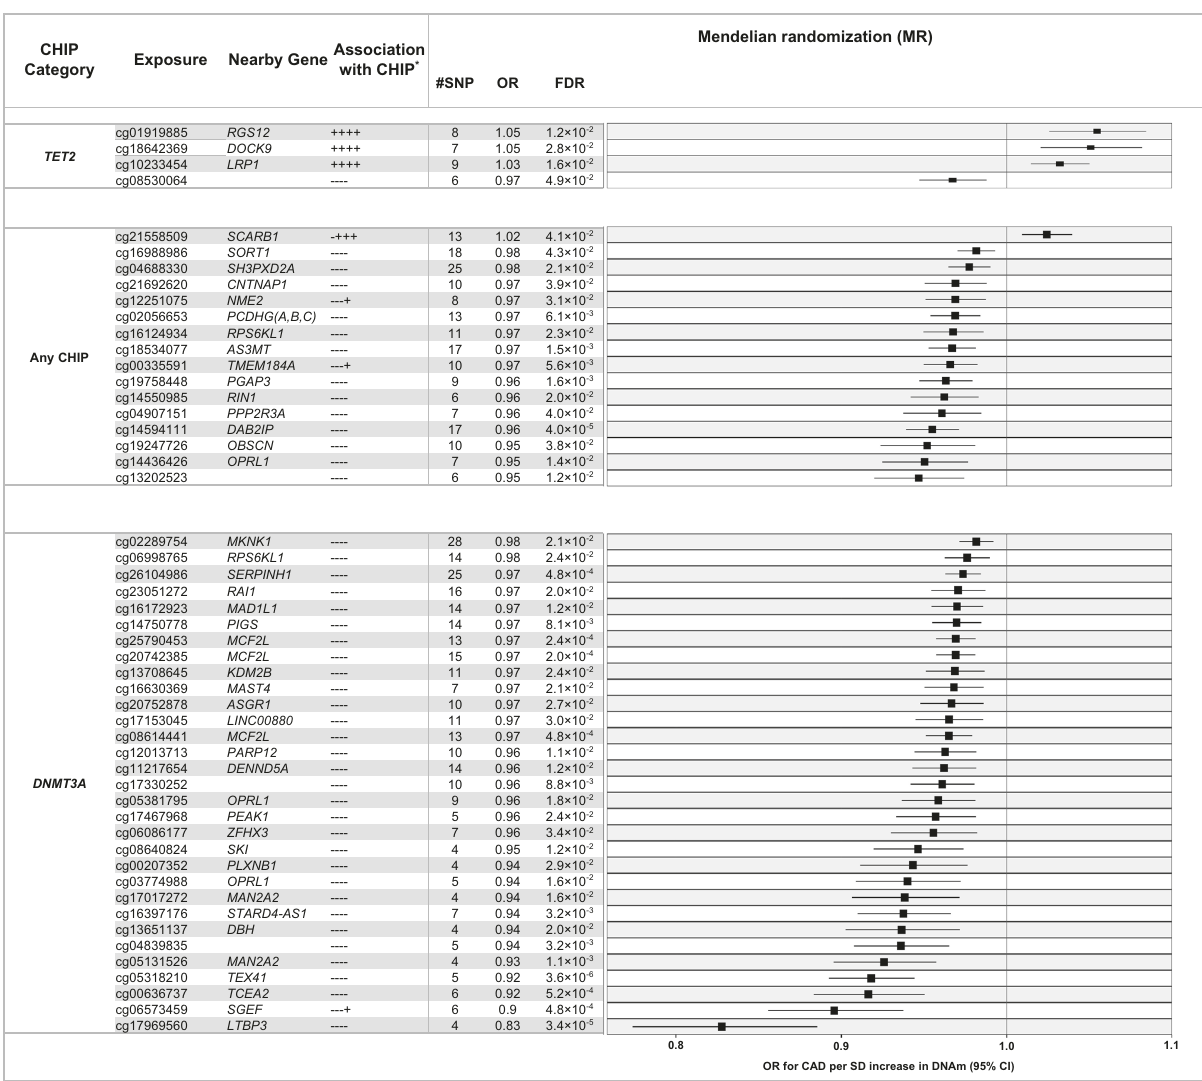
Fig. 3 | Mendelian randomization analysis of CHIP-associated CpGs and CAD risk. For sets of replicated CpGs associated with CHIP, DNMT3A , and TET2 ( y -axis), the odds ratio (x-axis, indicated by fi lled squares) re fl ects the change in CAD risk associated with eachSDincrease inDNAm, with lines representing 95%con fi dence intervals estimated by GSMR. GSMR analysis was based on published summary statistics (effect estimates) for cis-mQTL 39 ( N =32,851) and CAD GWAS 41